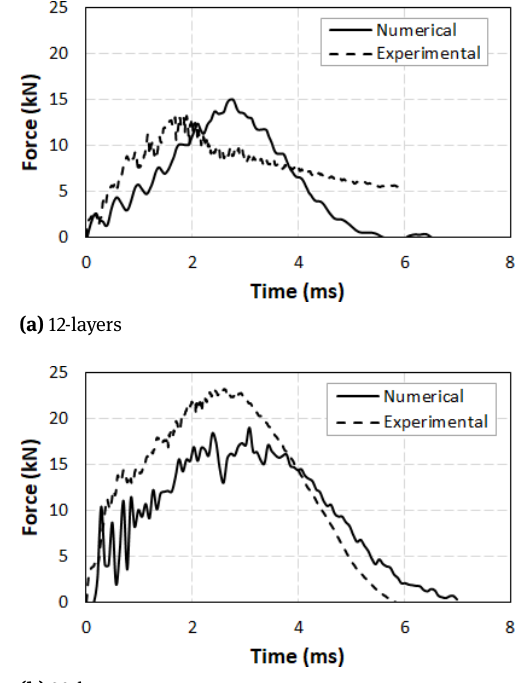
Figure 4: Experimental and numerical force-time histories of Kevlar Reinforced Epoxy